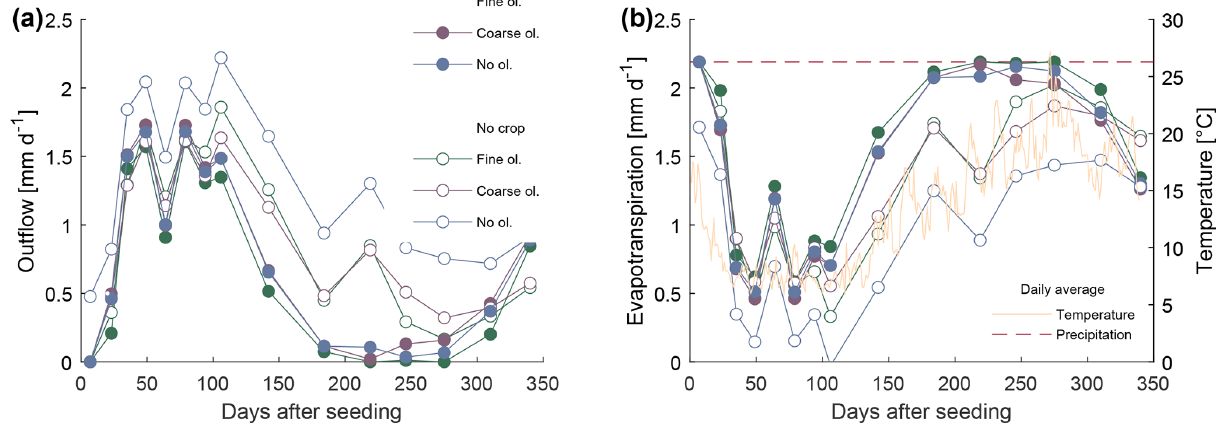
Figure 2. (a) Water flow from outlet; values refer to daily fluxes from the preceding interval. (b) Average daily temperature in the greenhouse and evapotranspiration, calculated from the difference of precipitation input and barrel outflow, relative to precipitation.